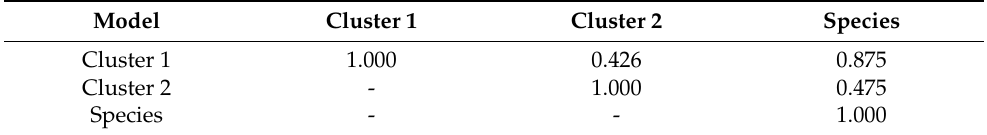
Table 4. Schoener’s D statistics used to measure the overlap between the three predicted ecological niches of Ilex